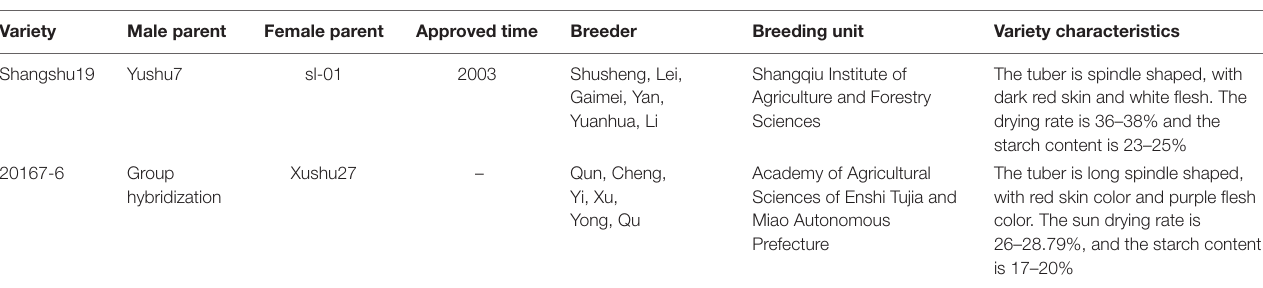
FIGURE 1 | The average daily temperature of the sweet potato hydroponic period in the test area. TABLE 1 | Information of sweet potato